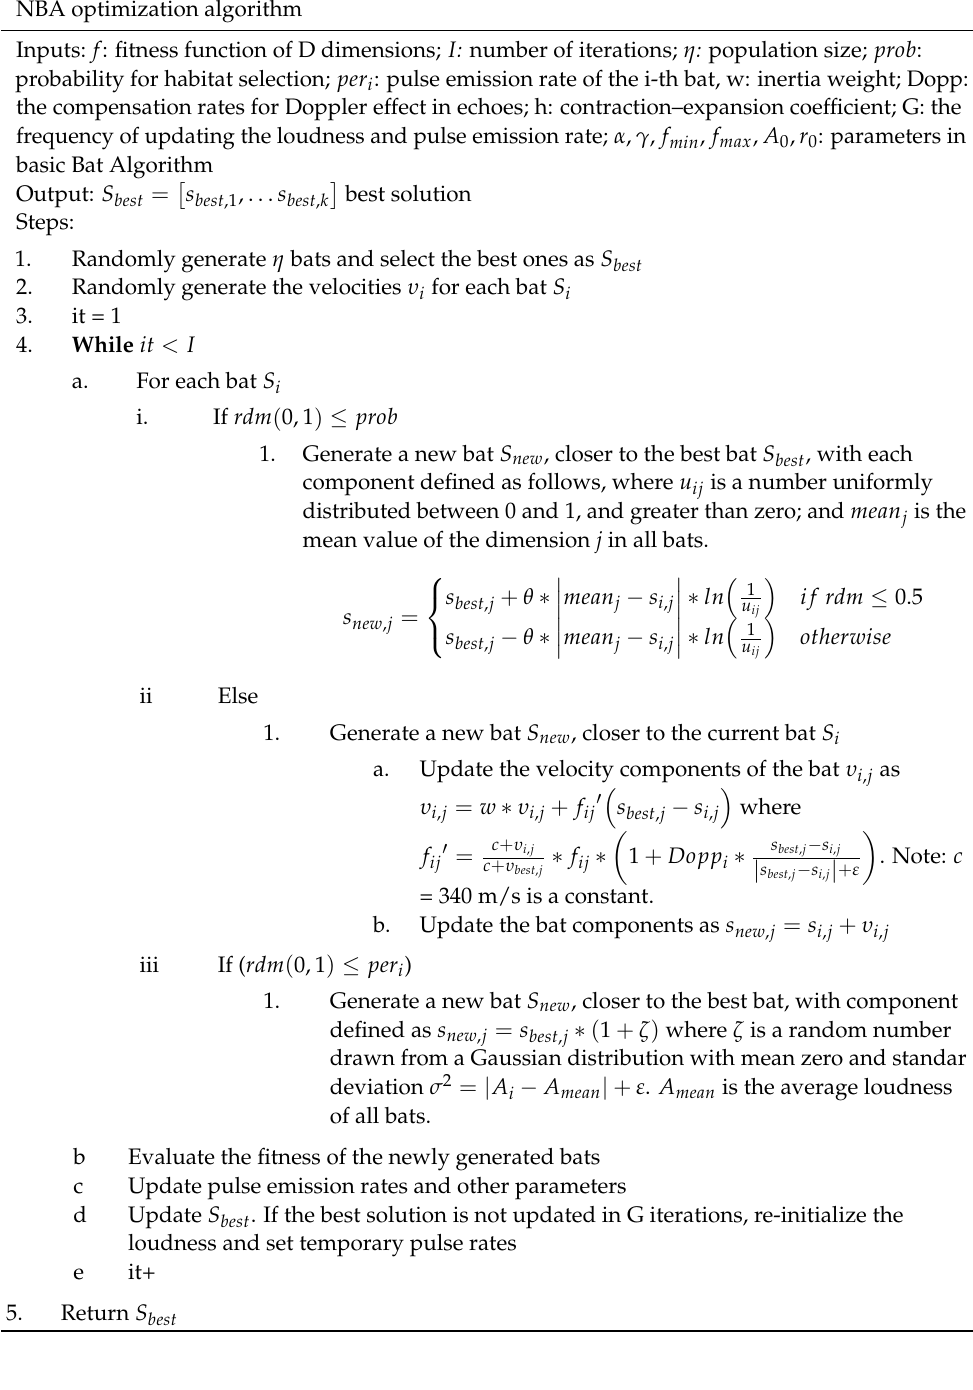
Algorithm 4. Pseudo code of the NBA